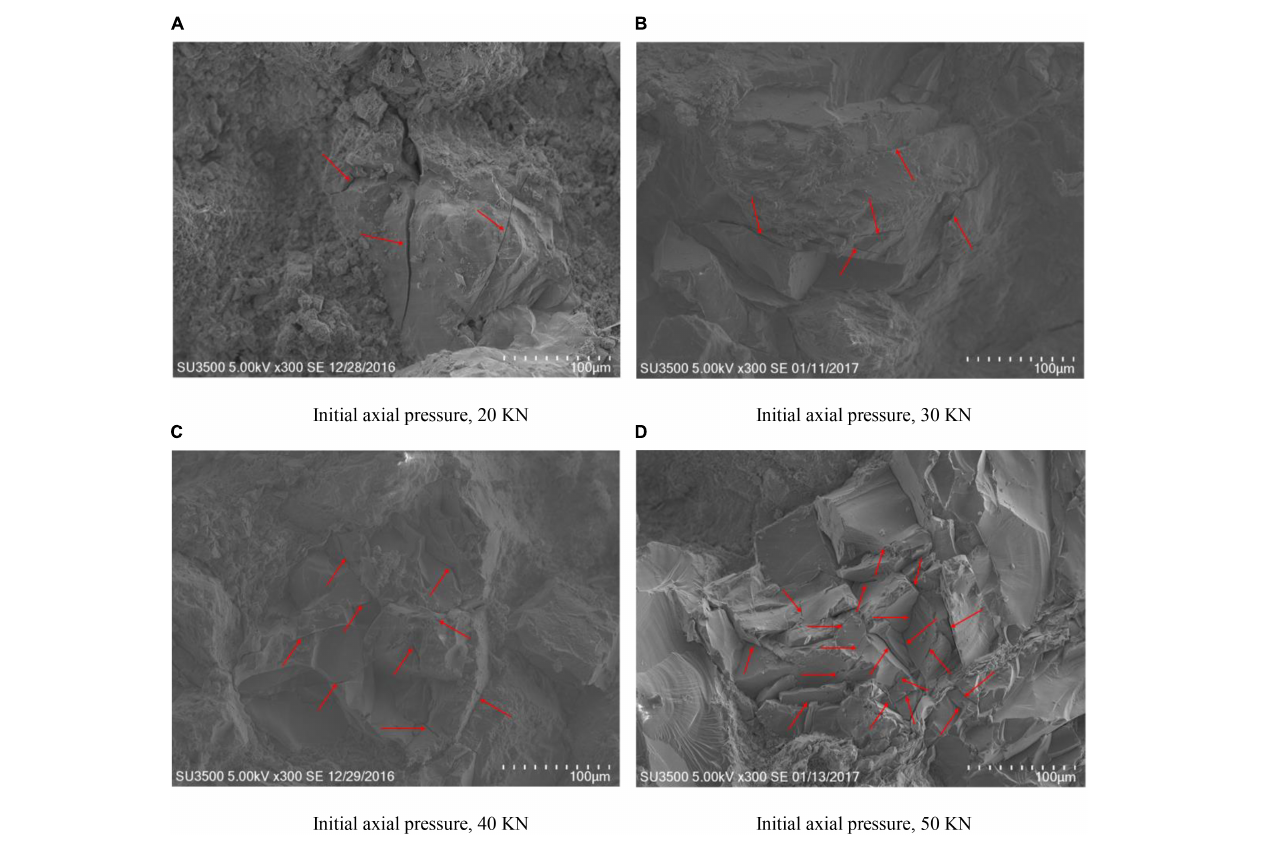
FIGURE 13 | SEM images showing the internal damage of the rock mass under different initial axial compression levels. (A) Initial axial pressure, 20 kN; (B) Initial axial pressure, 30 kN; (C) Initial axial pressure, 40 kN; (D) Initial axial pressure, 50